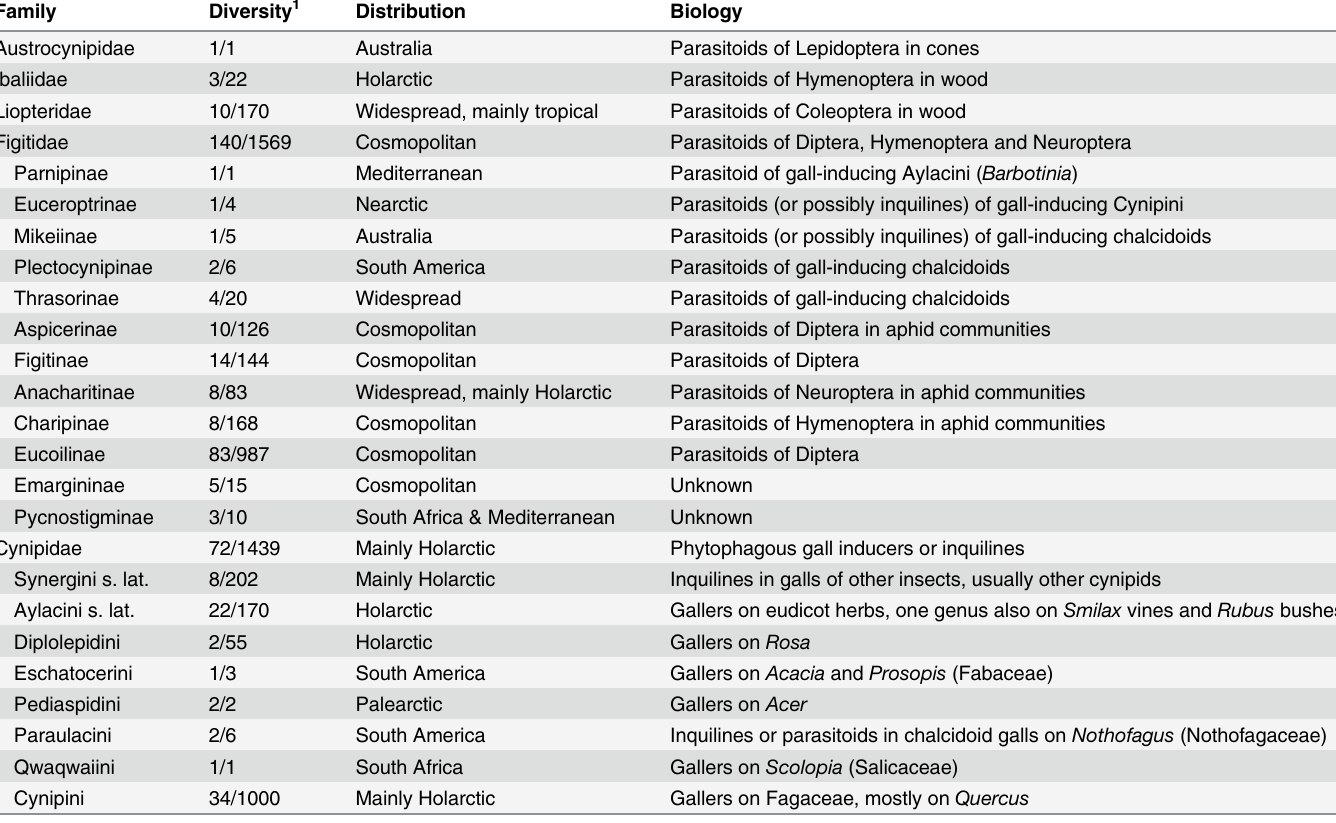
All parasitoids attack the larval stage of the host. 1 Number of genera /